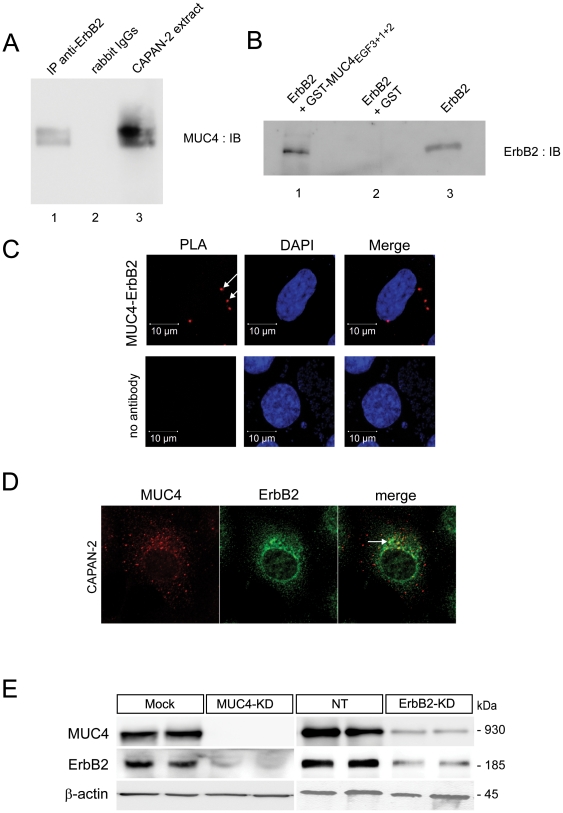
MUC4 and ErbB2 form a complex – Characterisation of MUC4-KD and ErbB2-KD cells.(A) Co-immunoprecipitation of 150 µg of CAPAN-2 cellular extract with anti-ErbB2 antibody (lane 1) or rabbit IgGs (lane 2). CAPAN-2 cell extract alone (lane 3). (B) ErbB2 immunoblot of GST pull-down of recombinant human ErbB2 protein with GST-MUC4EGF3+1+2 glutathione beads (lane 1) or GST glutathione beads (lane 2). Recombinant ErbB2 alone (lane 3). (C) In situ proximity ligand assay on CAPAN-2 cells. MUC4 and ErbB2 complexes (red dots) are indicated by an arrow. Nuclei were stained using DAPI. Control experiment was conducted in the absence of primary antibody. (D) Immunofluorescence detection of MUC4 (red) and ErbB2 (green) by confocal microscopy showed co-localization of the two proteins (yellow). (E) Expression of MUC4 and ErbB2 in two representative clones of MUC4-KD and ErbB2-KD cells and their respective controls (Mock and NT) by Western blotting.